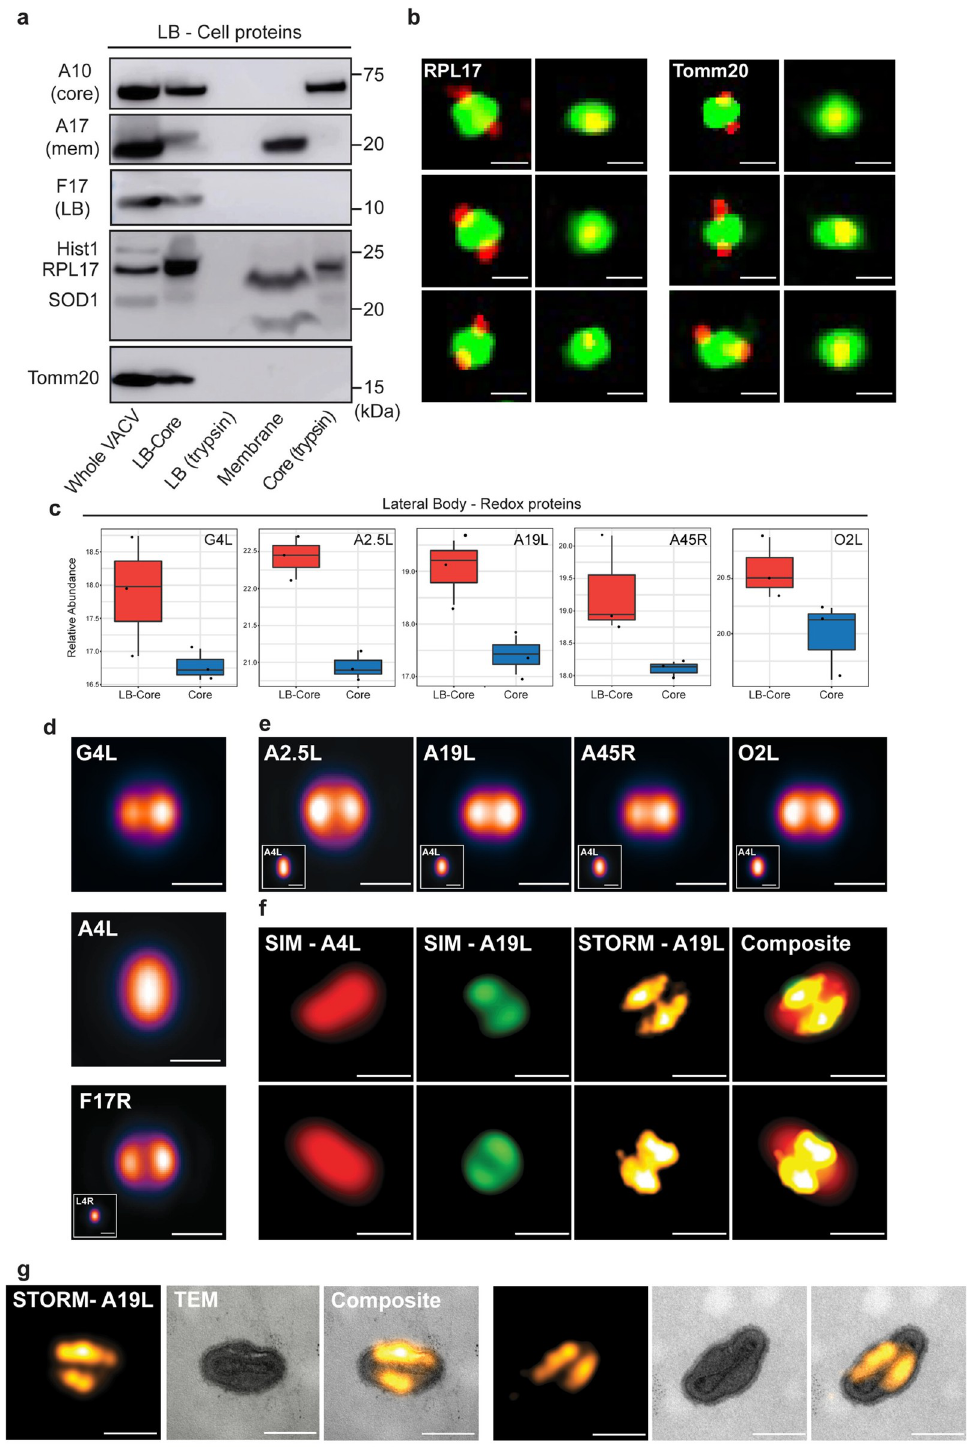
Fig 3. Cell and viral redox proteins reside in LBs. (a) Biochemical localization of candidate cellular LB proteins. MVs were subjected to controlled degradation as outlined in Fig 1A, and fractions subjected to immunoblot analysis for indicated viral and cellular proteins. Experiment was performed in triplicate and representative blots displayed. (b) SIM images (sagittal and frontal orientation) of RPL17 and Tomm20 localization in fractionated WR EGFP-A4L virions. Experiments were performed in duplicate and six representative virions displayed. (c) Relative abundance plots of the